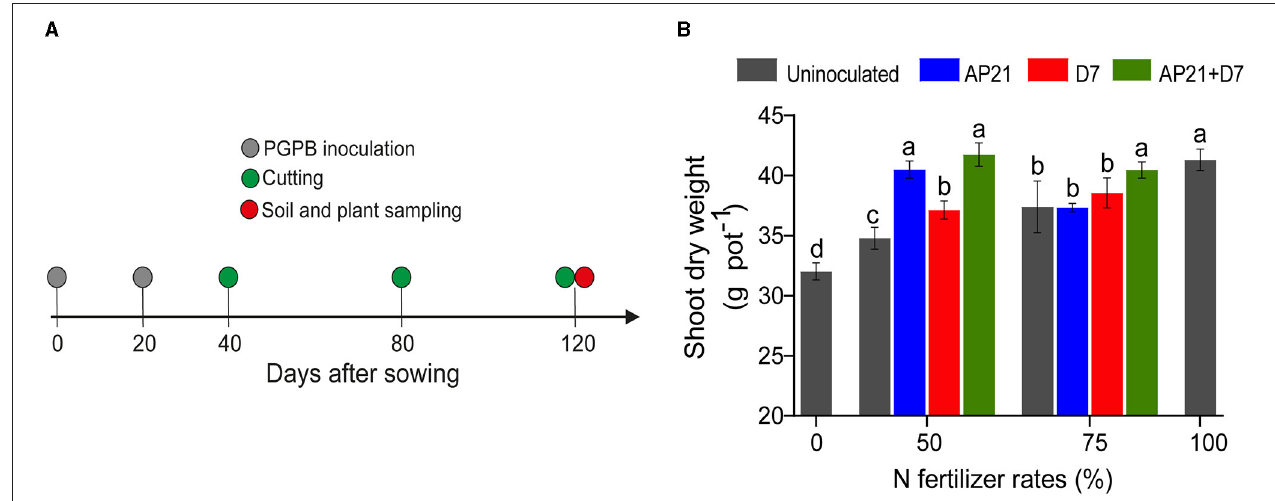
FIGURE 1 | Timeline of the experiment (A) . Effect of the inoculation of the strains Herbaspirillum sp. AP21, Azospirillum brasilense D7, and their co-inoculation with different nitrogen fertilization rates on plant biomass (B) . An untreated treatment was included at all fertilization doses as a control for inoculation. Error bars represent ± standard deviation. Different letters indicate significant differences based on Duncan’s test ( p < 0.05). Each value is the mean of three blocks with three replicates per